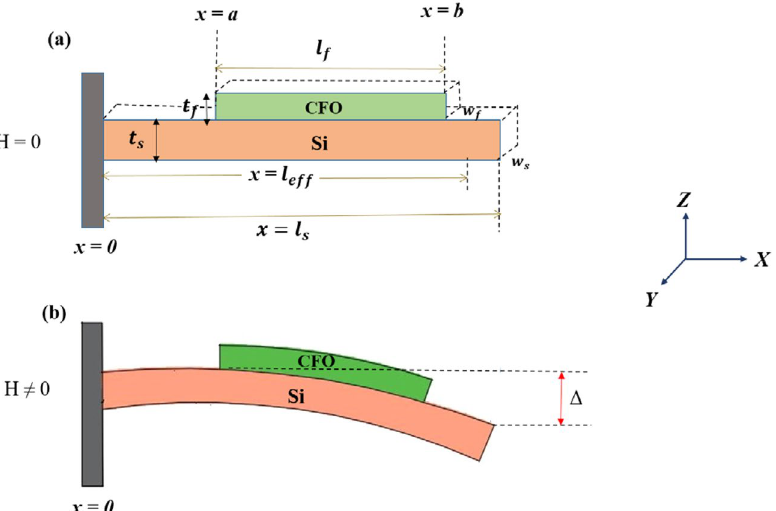
Figure 6. The schematic representation of the geometry of the CFO/Si composite structure with all the essential parameters. ( a ) CFO/Si composite when field is not applied. ( b ) Schematic view of the bending of CFO/Si composite due to the application of the